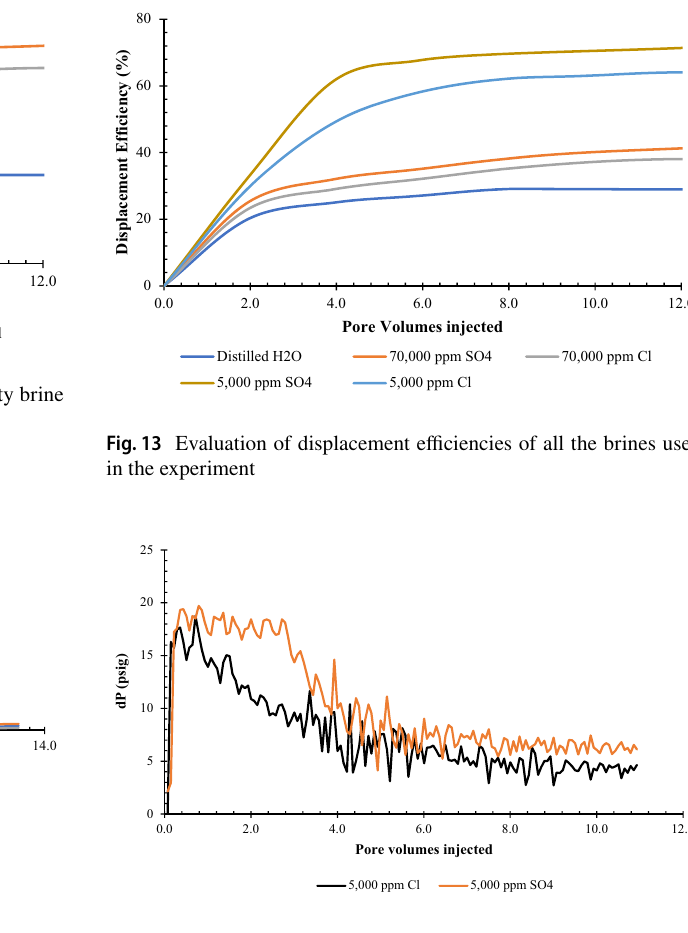
Fig. 14 dP versus pore volumes injected for low Cl and SO